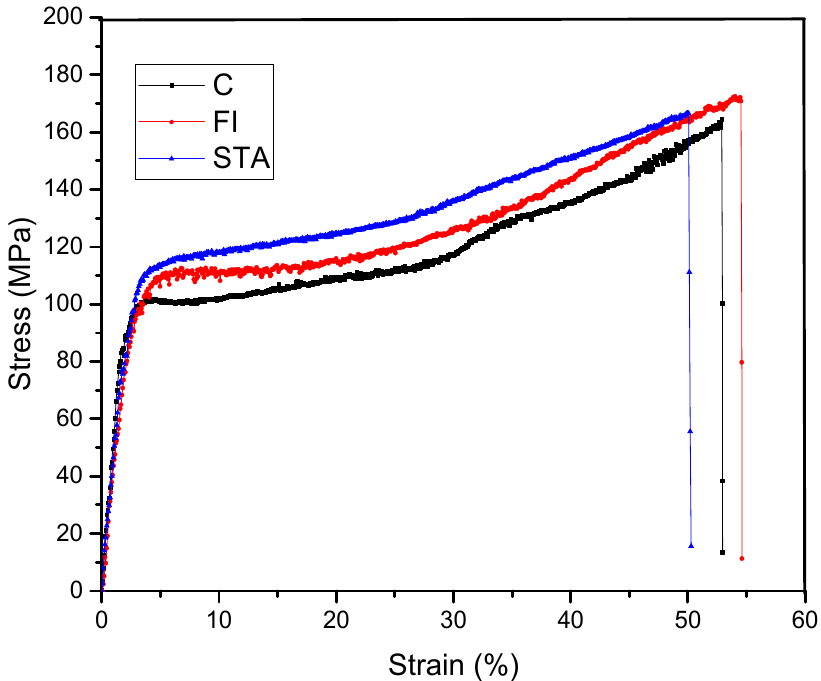
Figure 5. Typical stress–strain plots for C, FI, and STA hair. Table 1. Tensile properties of the C, FI, and STA hair.